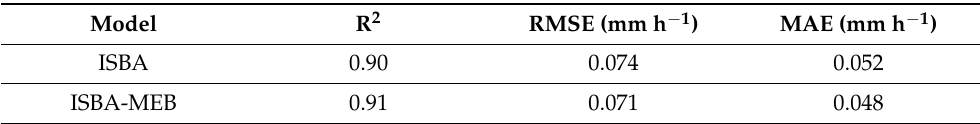
Table 6. Statistical scores on an hourly-scale between the sap flow measurements and transpiration estimated by ISBA and ISBA-MEB from 02/07/2015–27/08/2015.